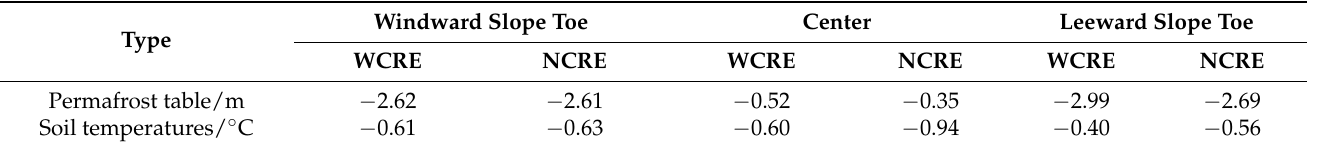
Table 5. Variations in the permafrost table and the soil temperature at the depth of 6 m beneath the WCRE and the NCRE on October 15 in the 50th year after the embankment